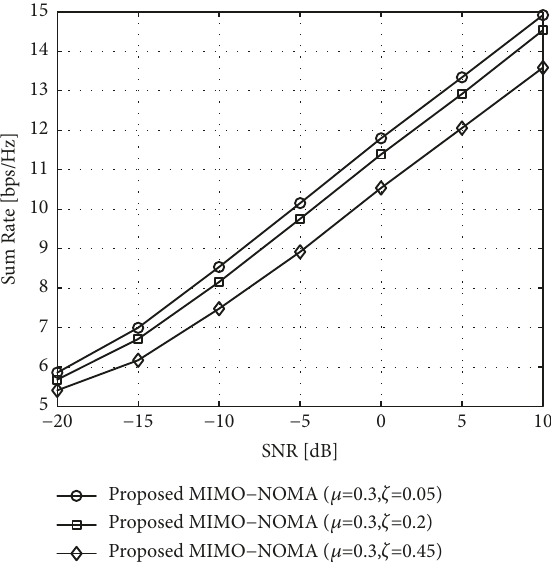
Figure 2: Sum rate performances of the proposed MIMO-NOMA system against SNR ( 𝜇 =0.3; 𝜁 =0.05, 0.2, and 0.45).